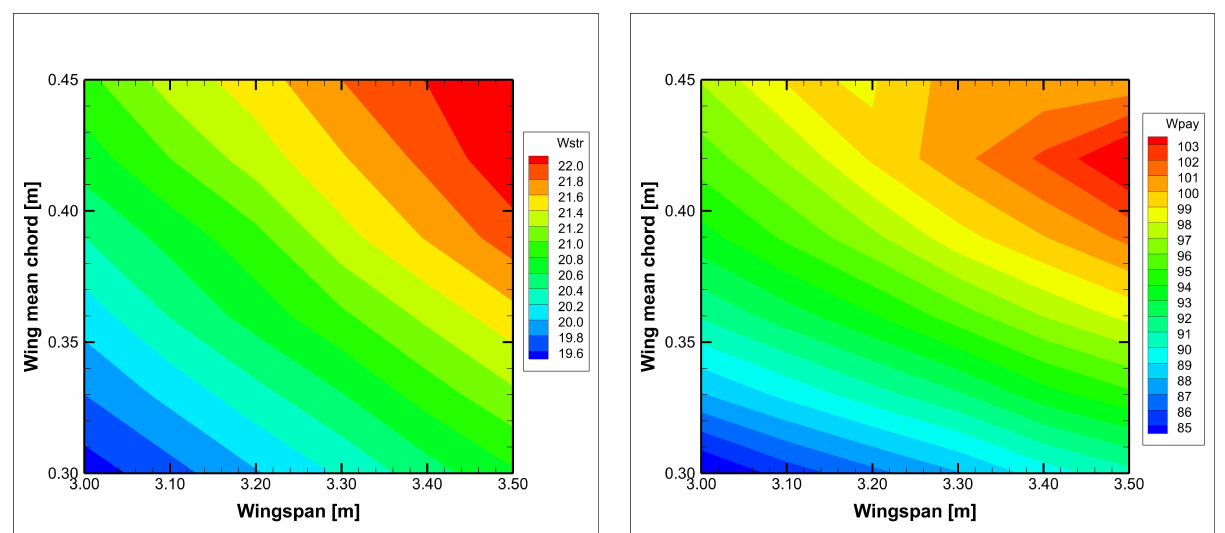
Figure 10: Structural weight [N] as a function of wingspan and wing mean chord.